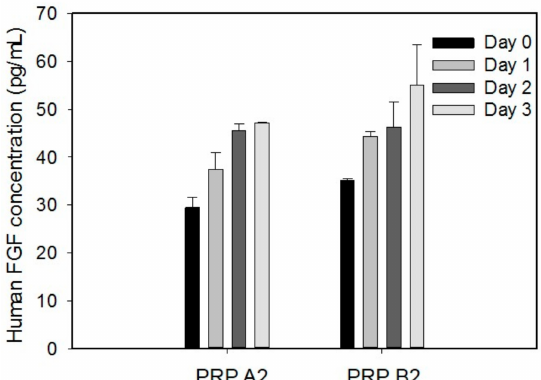
Figure 6. Human FGF (fibroblast growth factor) concentration in the culture medium at day 0, 1, 2, and 3. The PRP A2 and PRP B2 were respectively applied to the culture wells and cultured for 3 days. The supernatant was collected every day and human FGF concentration was measured. The data are the representative results from the blood sample collected from a 70-year donor. The data are collected from 3 repeated experiments and presented as mean ± standard deviation (SD).